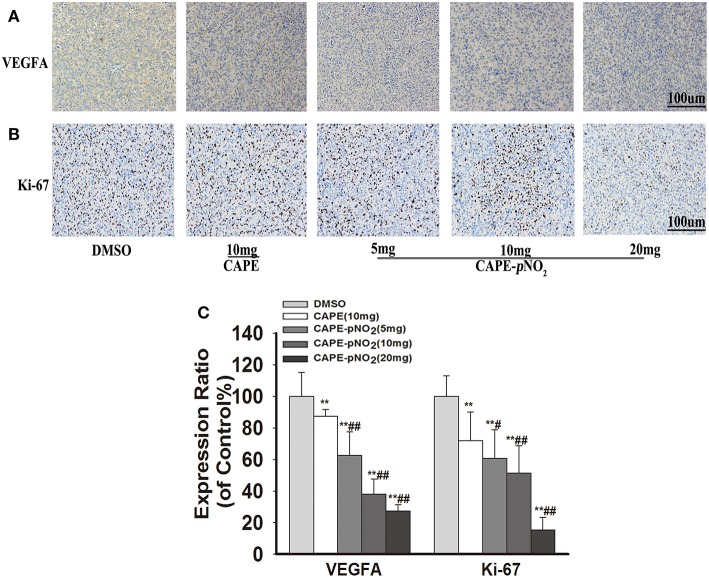
CAPE-pNO2 reduced the protein expression levels of VEFGA and Ki-67 in tumor tissues. As indicated by IHC, the brown areas indicated the positive proteins expression of VEGFA and Ki-67. The integrated option density value was used to analyze the protein expression level. (A) The protein expression of VEGFA. (B) The protein expression of Ki-67. (C) A graphical representation of quantitative data shows the relative proteins expression of VEGFA and ki-67. Values represent the mean ± SD from three independent experiments; *p < 0.05, **p < 0.01: CAPE and CAPE-pNO2 compared with DMSO group; #p < 0.05, ##p < 0.01: CAPE-pNO2 (5, 10 and 20 mg/kg) compared with CAPE (10 mg/kg).